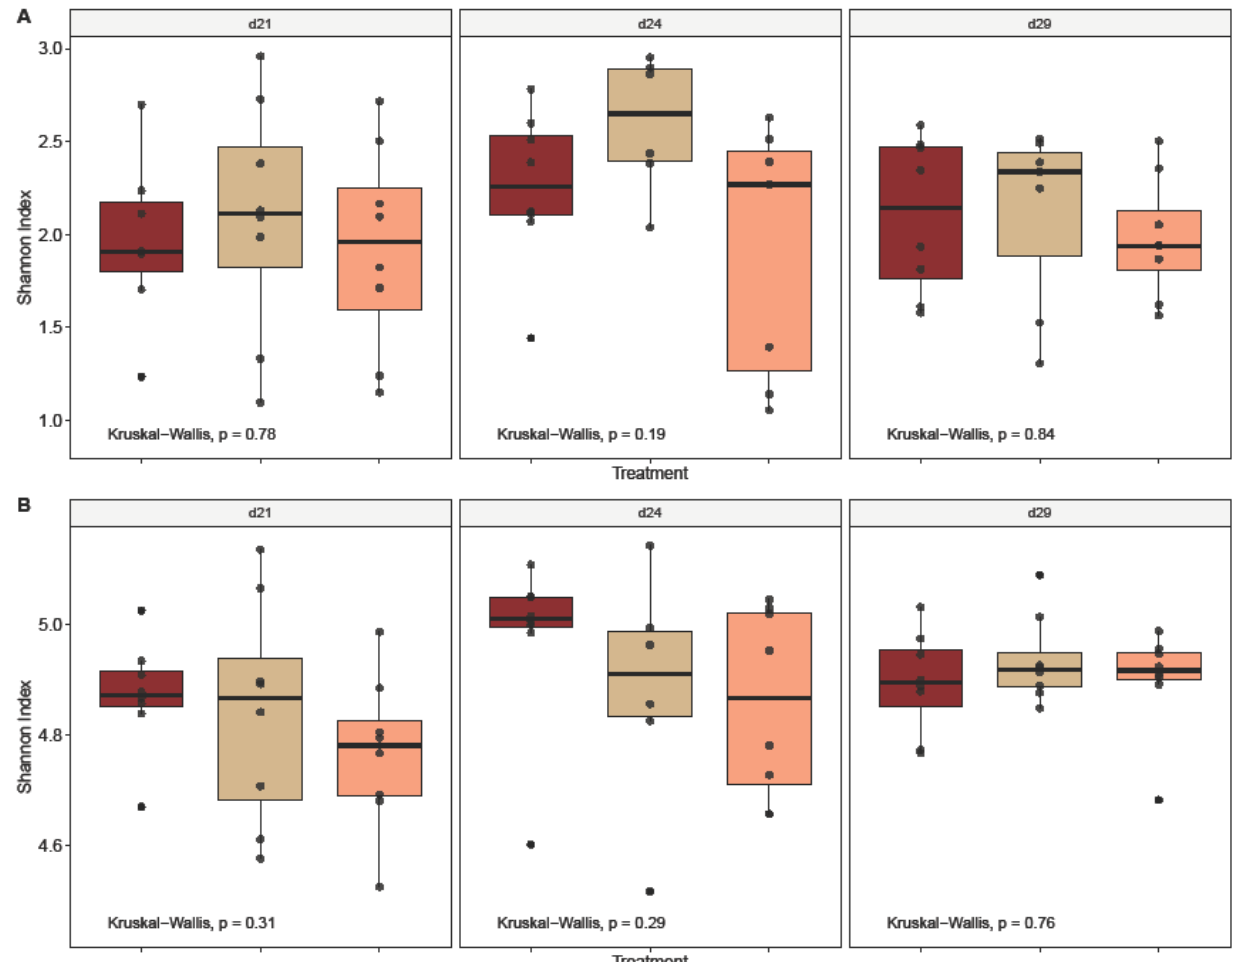
Figure 2. Treatment effect on alpha diversity (Shannon Index) for ( A ) ileum and ( B ) ceca samples collected at days 21, 24, and 29 of age from chickens administered butyrate (UltraGuard™ -DUO, 500mg/kg), salinomycin (Sacox ® , 69 mg/kg), or no dietary supplement (control). Overall treatment effects were identified using a Kruskal – Wallis test (provided in the bottom of each graph) and pairwise differences between treatments were determined by pairwise Wilcoxon rank sum tests (provided as horizontal bars with p values). Only significant pairwise differences are visualized.